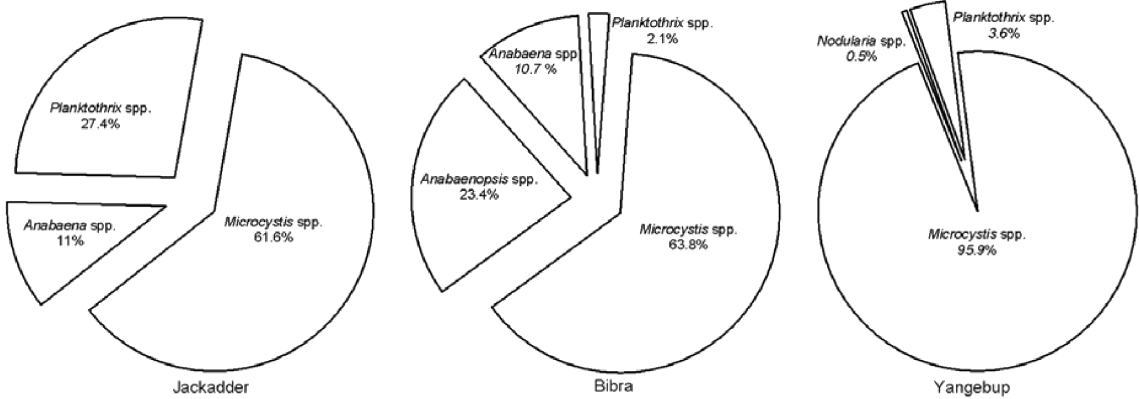
Figure 4. Mean biomass (µm 3 mL − 1 ) proportions of potentially toxic cyanobacterial genera in Jackadder, Bibra and Yangebup lakes during the study period.